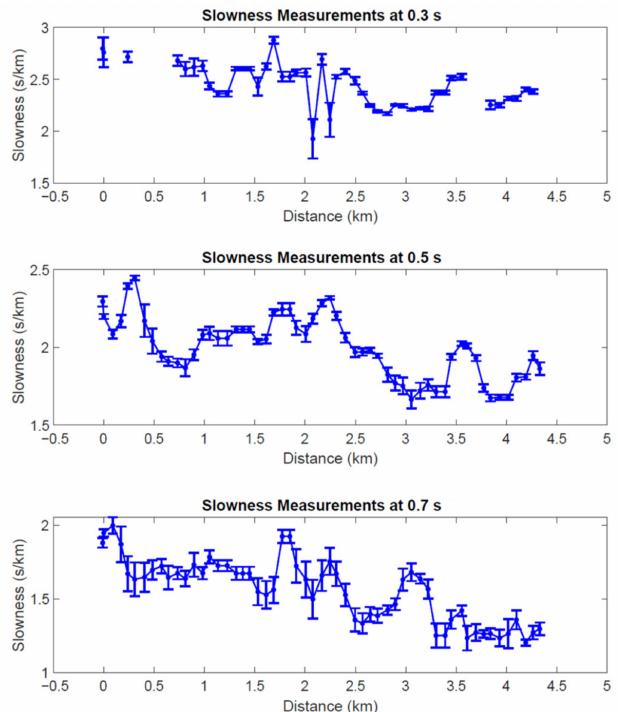
Figure 5. The slowness measurements along the entire array at periods of 0.3 s, 0.5 s, and 0.7 s. The error bars show the uncertainties of the mean